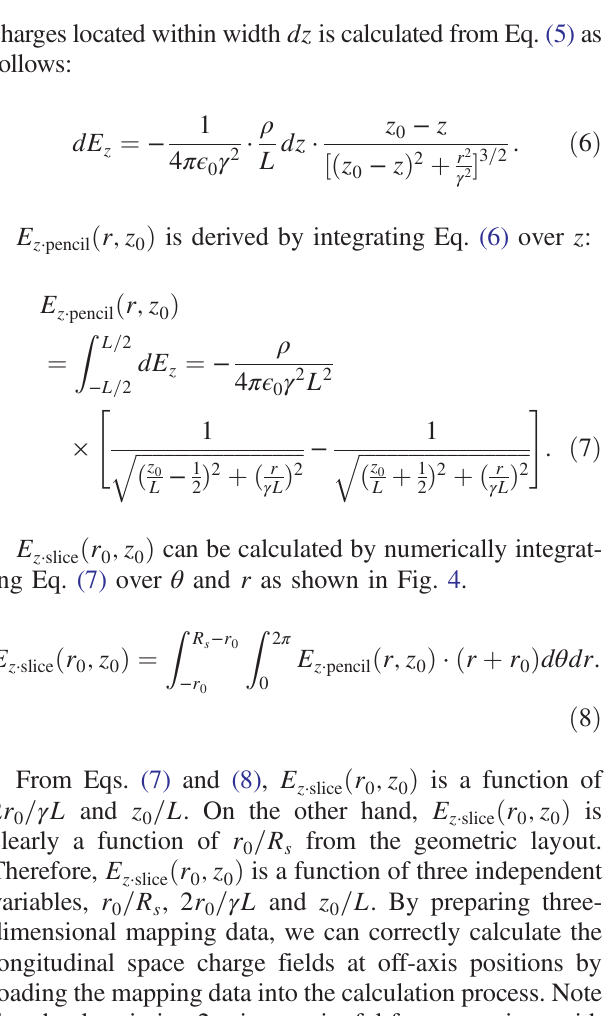
FIG. 5. Calculation model of longitudinal space charge field produced by a pencil